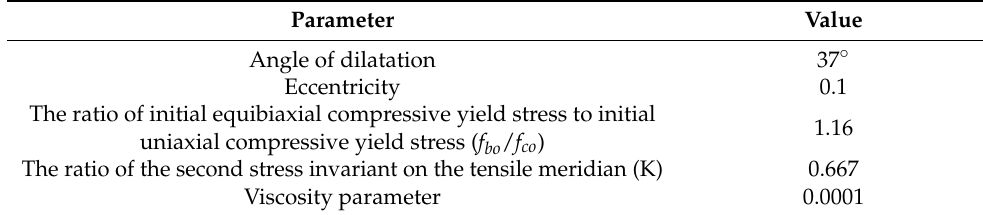
Table 9. CDP model parameters under compound